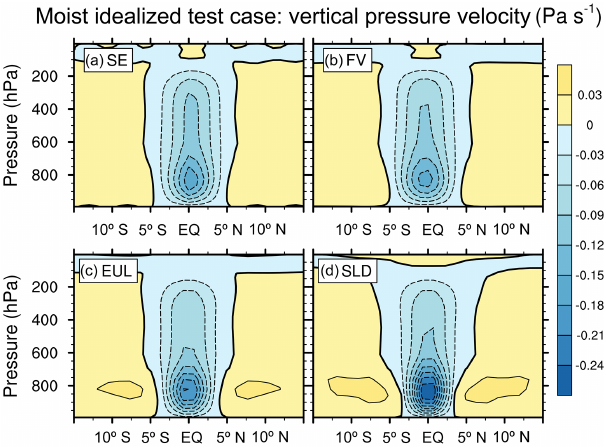
Figure 13. Latitude–pressure profiles of time-mean, zonal-mean vertical pressure velocity in MITC for (a) SE, (b) FV, (c) EUL, and (d)